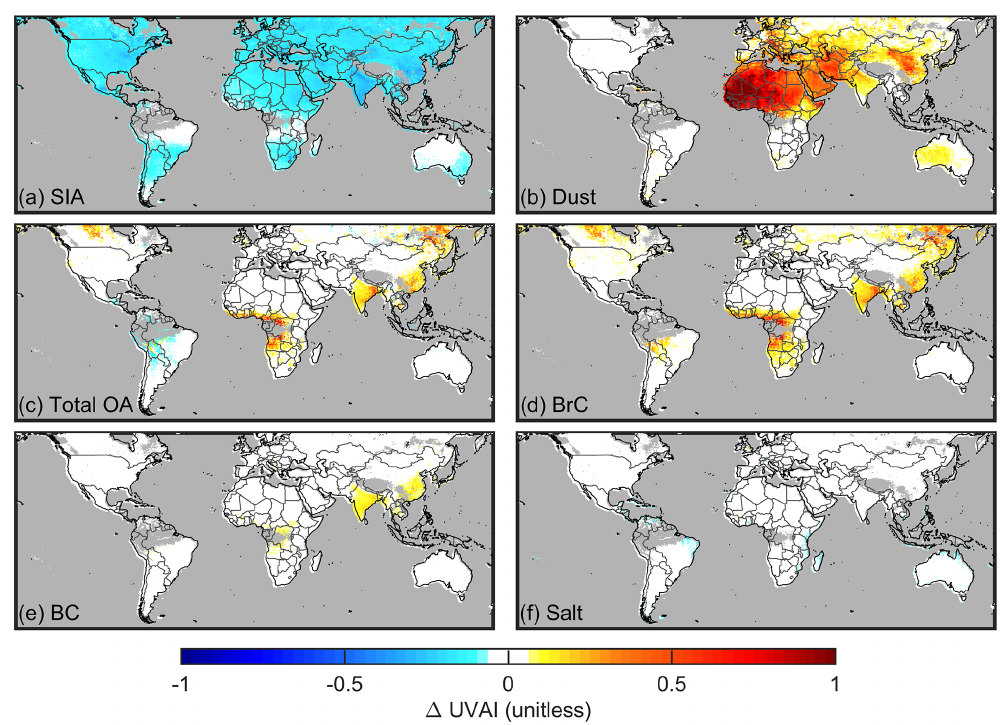
Figure 8. Annual mean change in simulated UVAI values for 2008 due to the doubling of concentrations of (a) secondary inorganic aerosol (SIA), (b) dust, (c) total organic aerosol (OA), (d) brown carbon (BrC), (e) black carbon (BC), and (f) sea salt from the GEOS- Chem simulation. Grey indicates persistent cloud fraction greater than